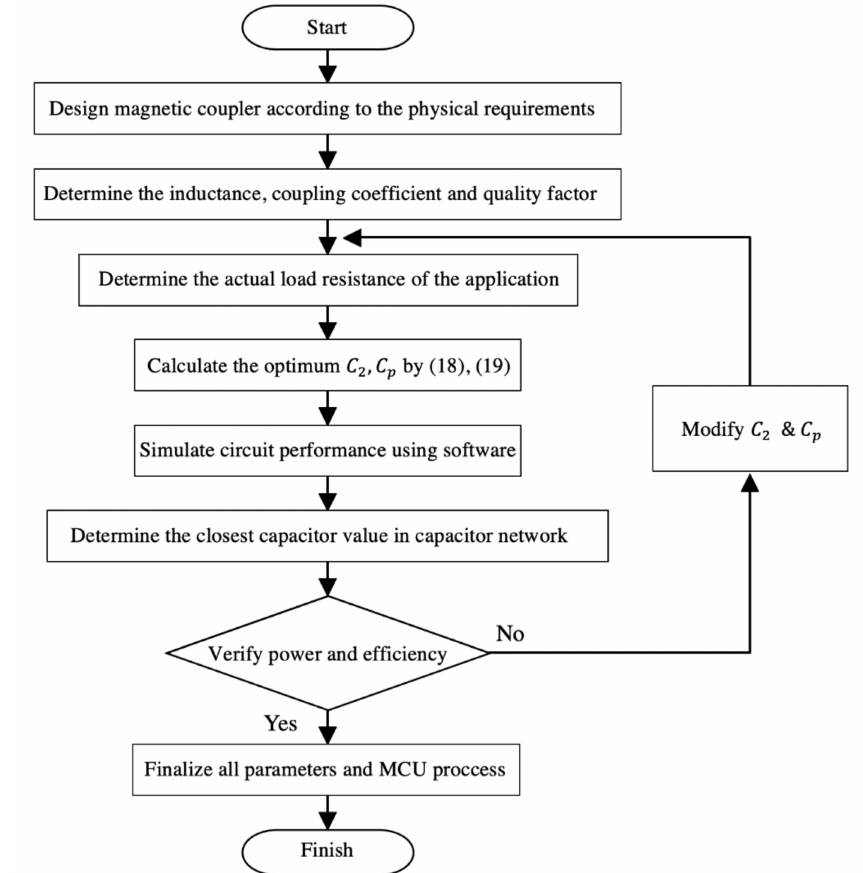
Figure 7. Design process of the proposed